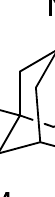
the antipsychotic drug anisopirol (Figure 5), the compound of this group with the highest